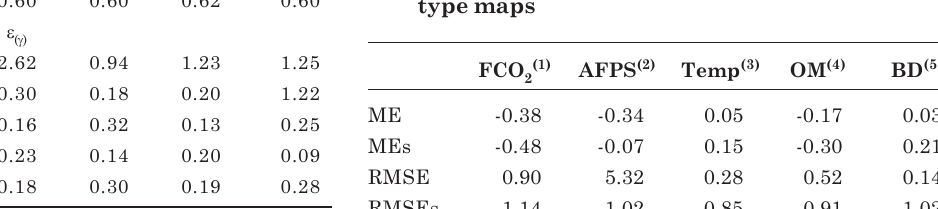
Table 4. Mean error (ME), standardized mean error (MEs), root mean square error (RMSE), standardized root mean square error (RMSEs), applied to the external validation data for the E- type